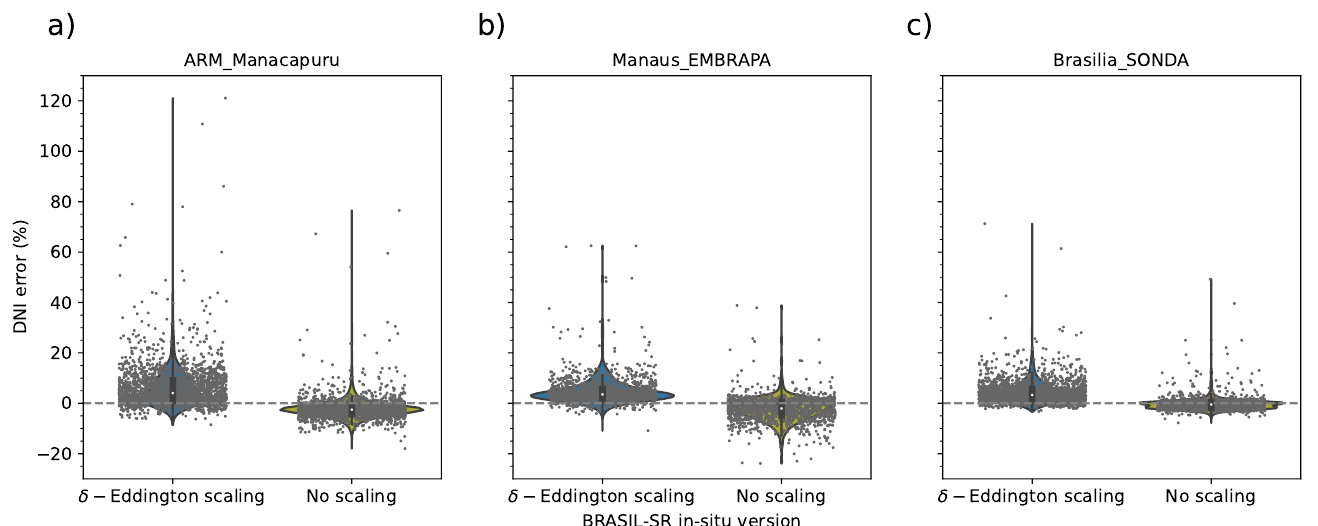
Figure 10. Combined violin and strip plots of the deviations of the BRASIL-SR DNI outputs with δ -Eddington scaling and without scaling for the in-situ experiment : ARM_Manacapuru ( a ), Manaus_EMBRAPA ( b ) and Brasilia_SONDA ( c